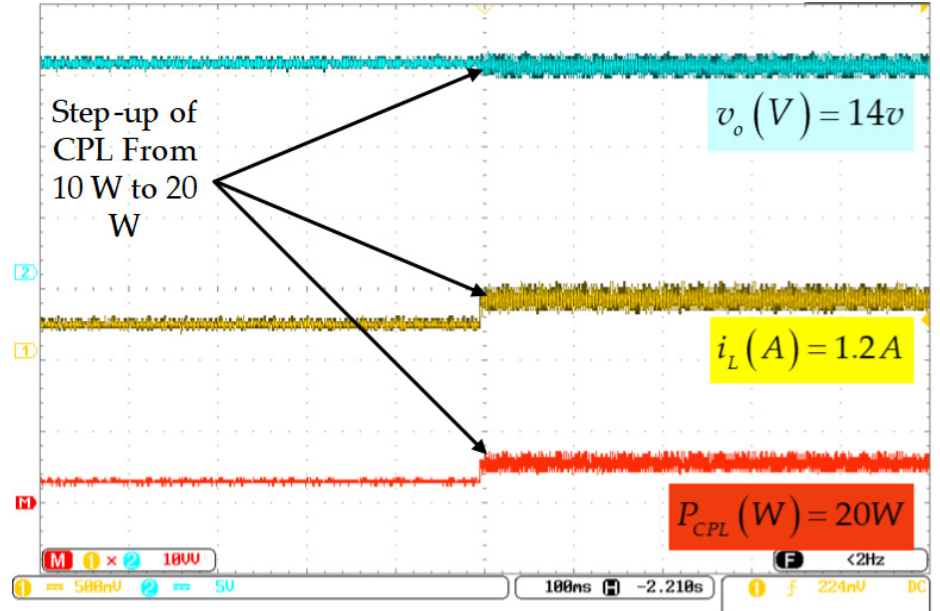
Figure 16. Experimental results for increased power demand of the CPL from 10 W to 20 W.